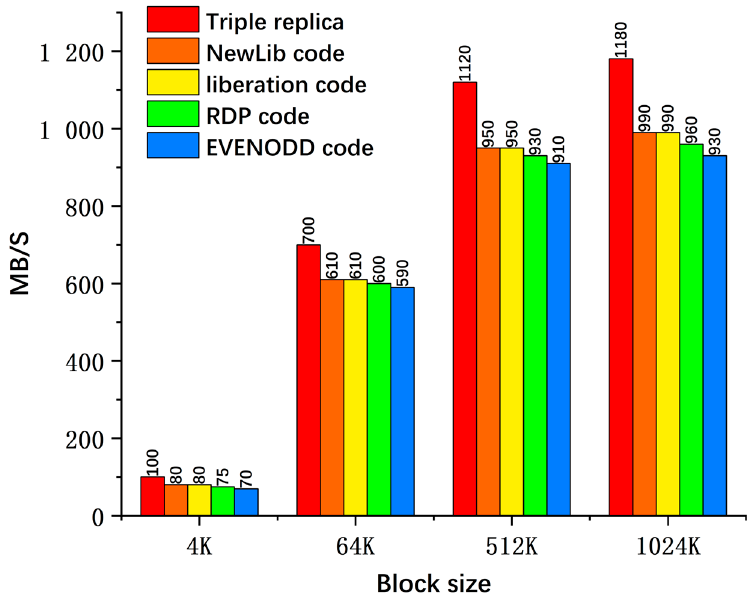
Figure 10. The throughput in the sequential reading.